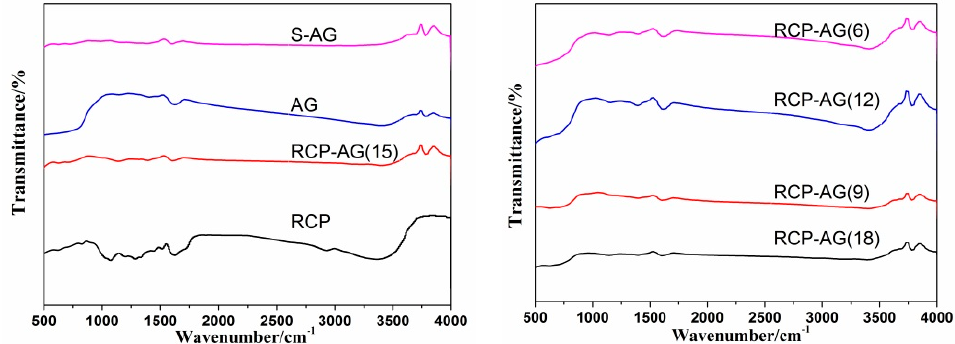
Figure 5. FTIR spectra of samples.